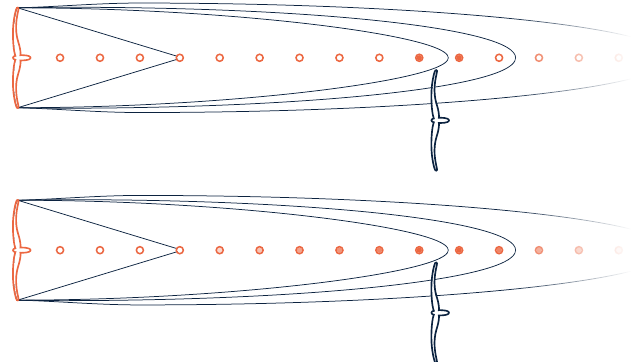
Figure 1. Interaction between OPs and a turbine: the initial case only considered the two closest OPs (upper figure), while the weighted case considers a broader range of OPs (lower figure) to estimate the wind field states at the downstream turbine